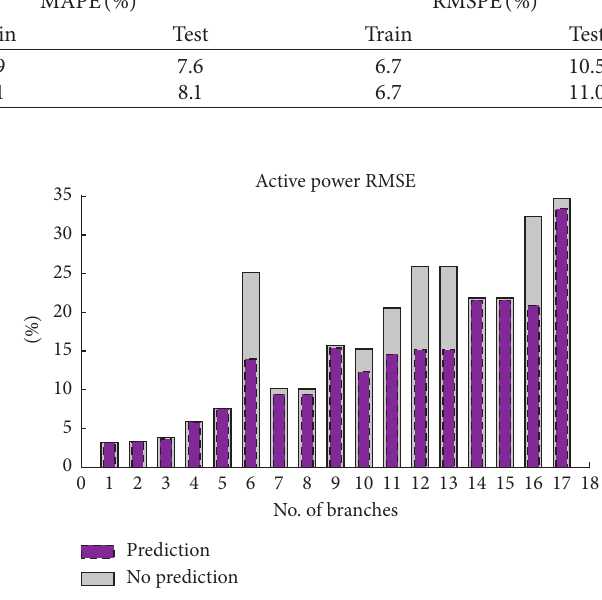
Figure 12: Active power RMSEs obtained with and without the ANN-based prediction.